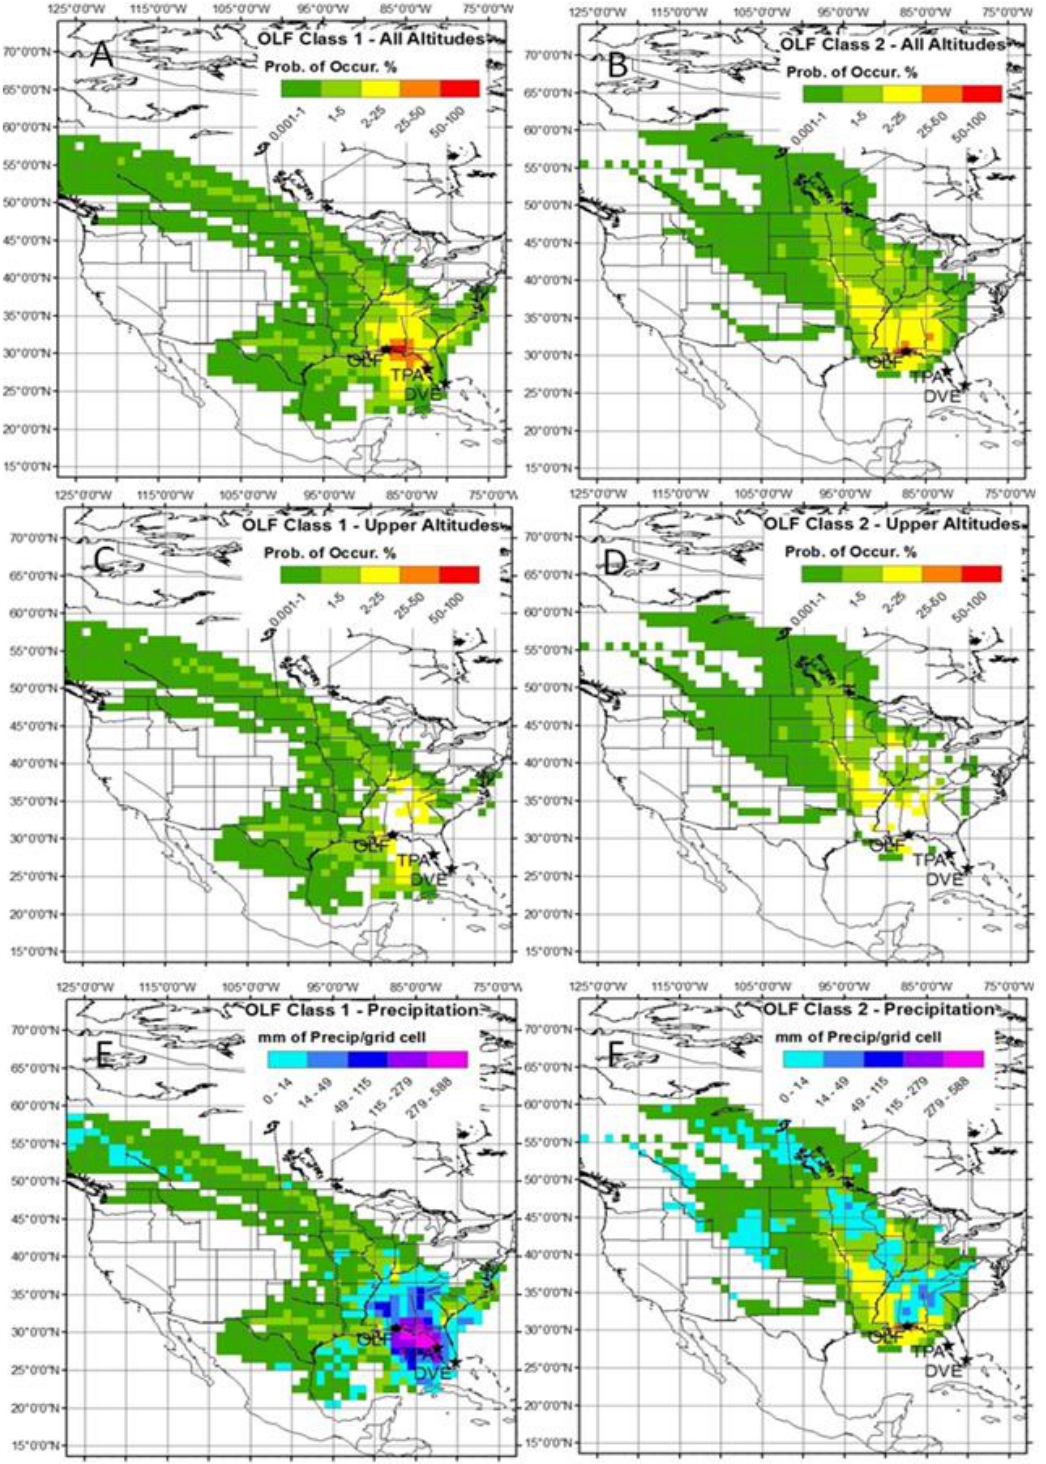
Fig. 6. Gridded frequency distributions of back trajectories for the five highest GOM concentration event days Classes 1 and 2 at the OLF